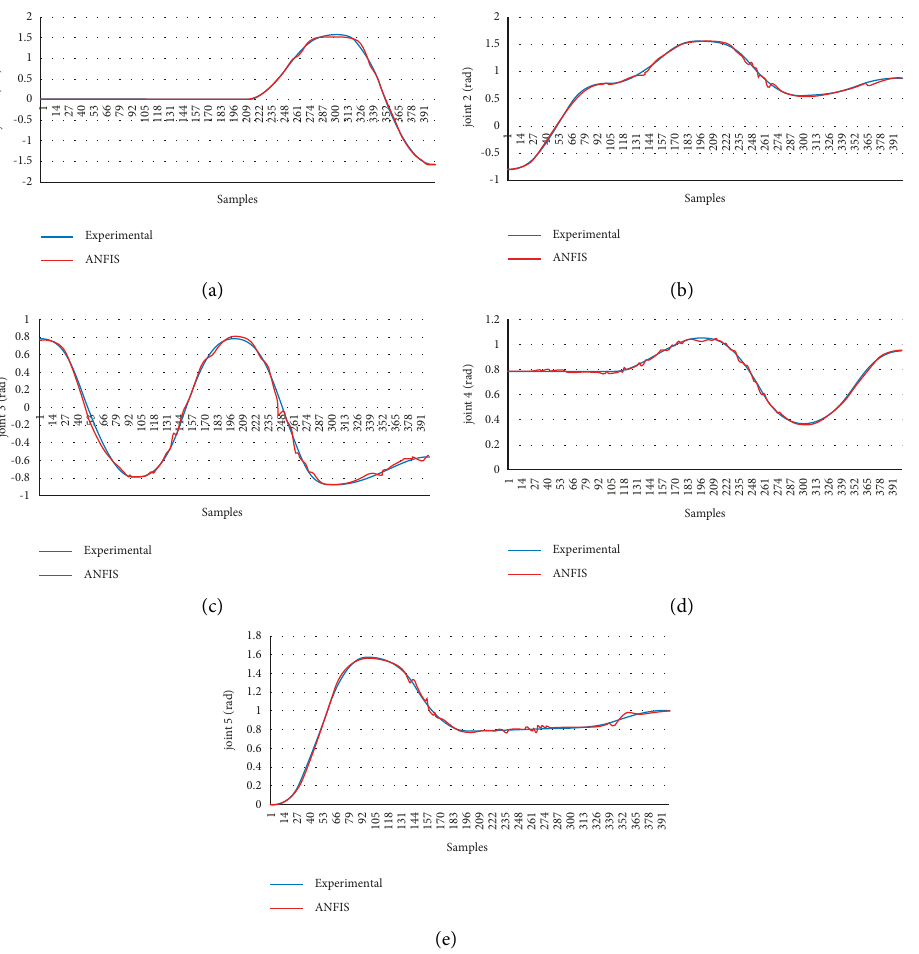
Figure 12: Comparison between predictive and experimental results (a) SCM-ANFIS for joint 1; (b) GP-ANFIS for joint 2; (c) GP-ANFIS for joint 3; (d) GP-ANFIS for joint 4; (e) GP-ANFIS for joint